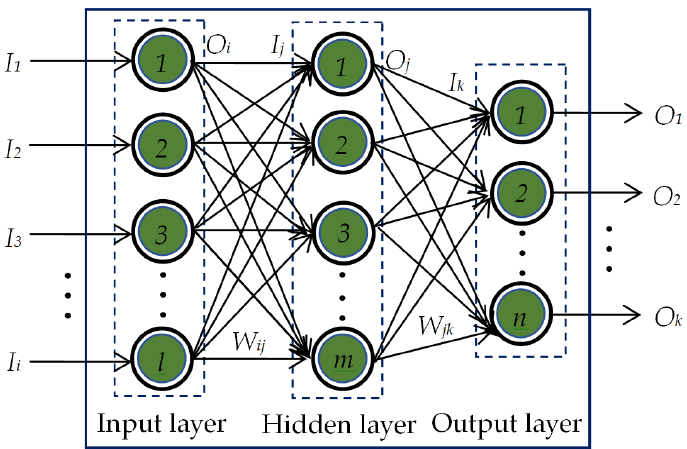
Figure 5. The basic architecture of a single ‐ hidden ‐ layer PRN.